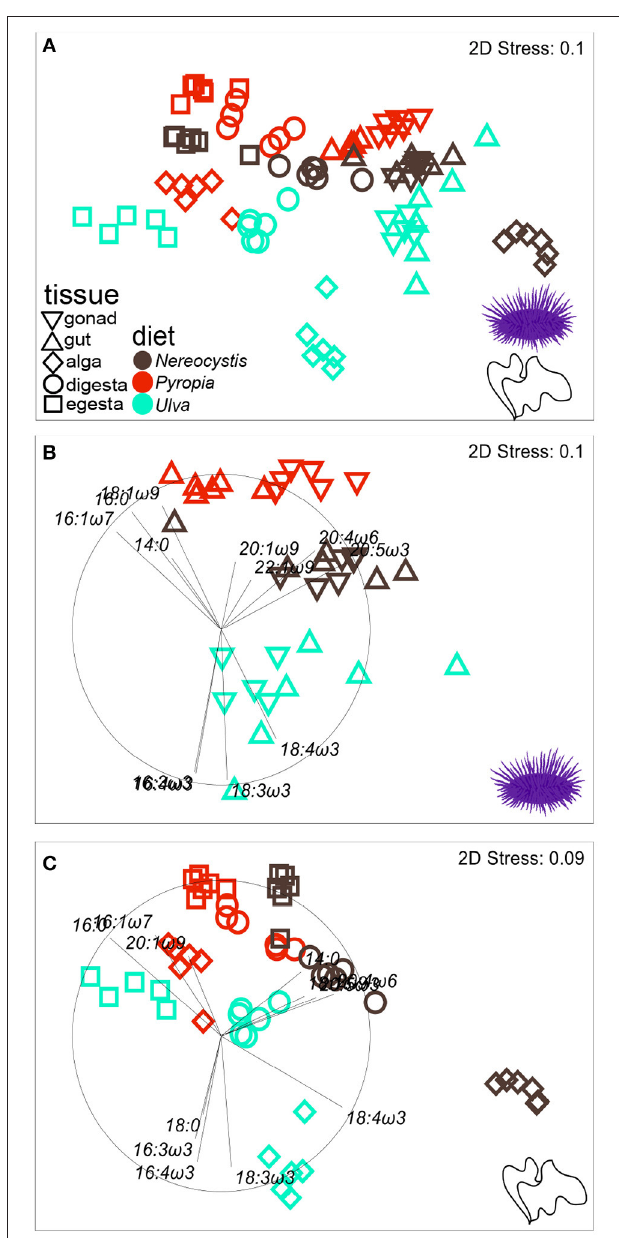
FIGURE 4 | nMDS plot (Euclidean distance) showing proportions of FA ( n = 37) in tissues from S. purpuratus fed monoculture diets of Nereocystis, Pyropia, or Ulva .Tissues from the feeding assay at OIMB (A) are included along with subsets representing (B) urchin tissues and (C) macroalgal tissues. Vectors indicate the top five FAs identified by SIMPER analyses that distinguish FA profiles between tissues and diets ( Tables 3–5 , Supplementary Tables 7–11) and are included to visualize how FAs contribute to the relative distributions of (B) urchin and (C) macroalgal tissues.